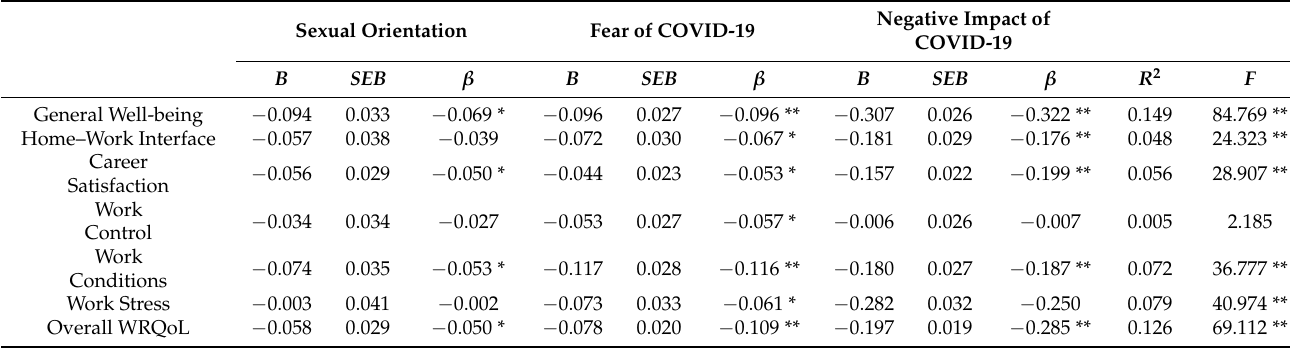
Table 4. Multiple linear regression analyses predicting sexual orientation, fear of COVID-19, and negative impact of COVID-19 effects on WRQoL.